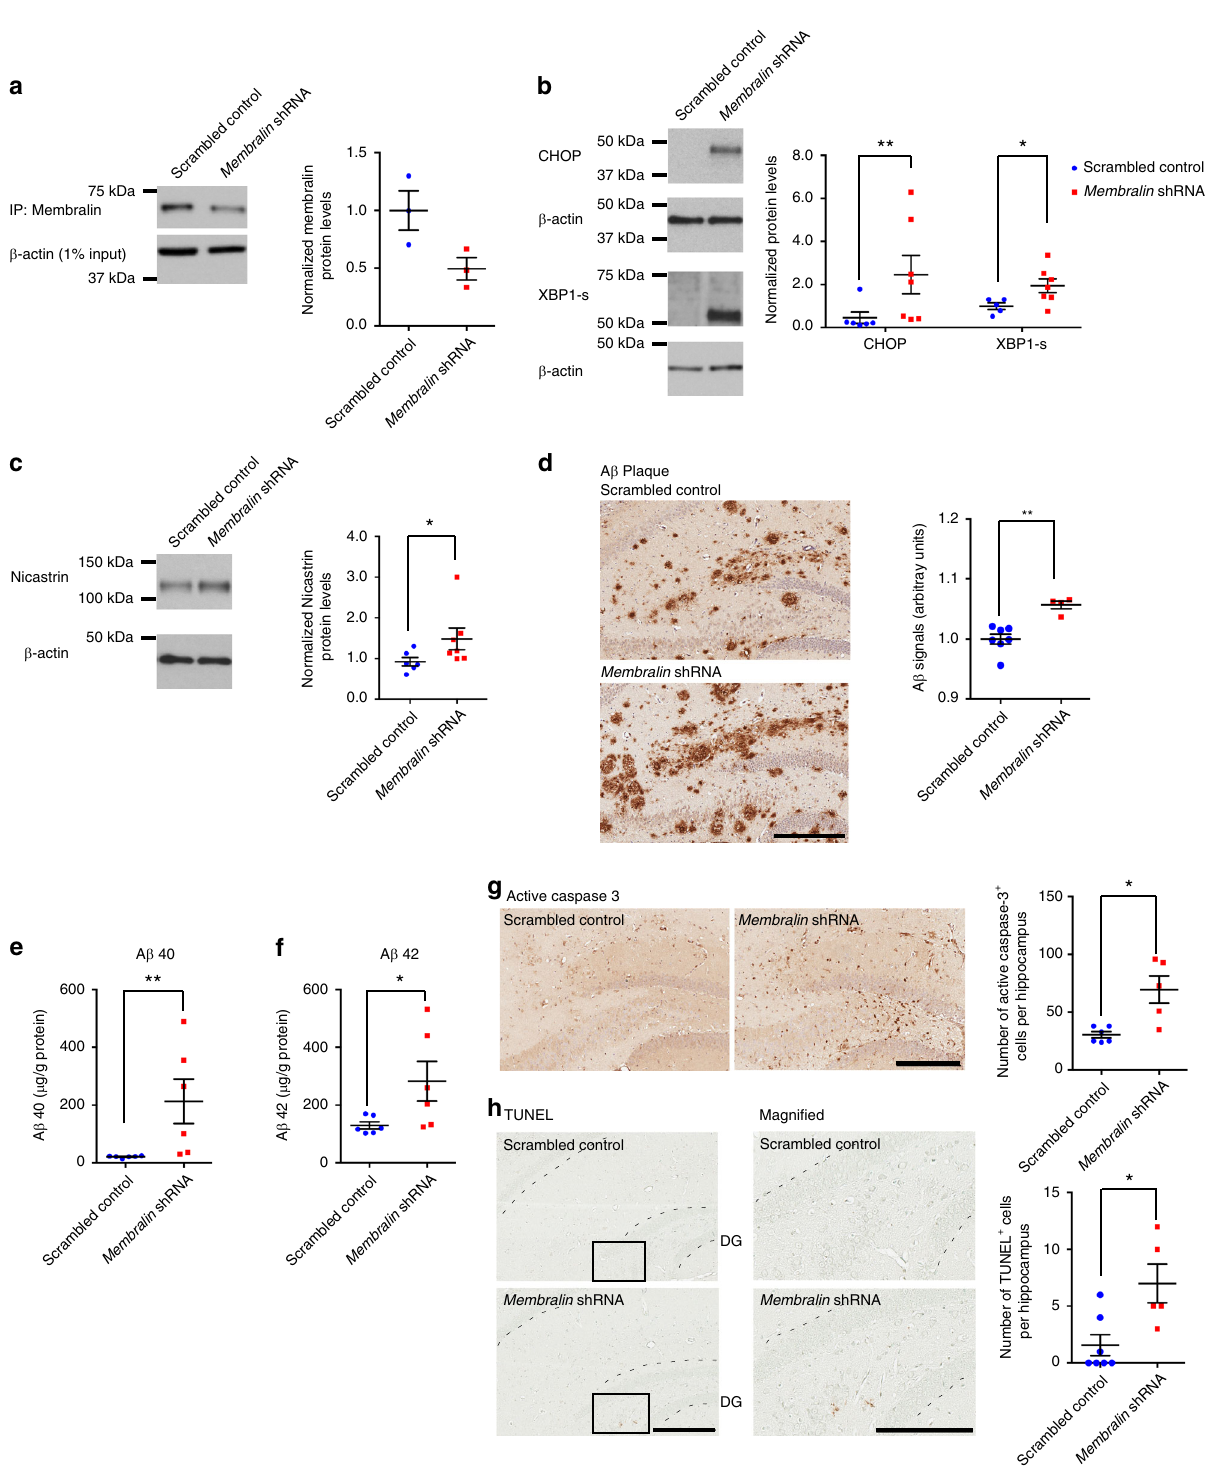
Fig. 6 Modulation of membralin expression in TgCRND8 mice. a Membralin protein levels from TgCRND8 mouse hippocampus injected with scrambled control or membralin shRNA constructs. Protein levels were determined by immunoprecipitation and immunoblot using an anti-membralin antibody. Protein levels were normalized relative to β -actin ( n = 3 mice per group). b XBP1-s and CHOP protein levels from TgCRND8 mouse hippocampus injected with scrambled control or membralin shRNA constructs. c Nicastrin protein levels normalized to β -actin in the hippocampus of scrambled control ( n = 6) and membralin shRNA ( n = 7) injected mice. d A β plaque staining and quanti fi cation was determined by staining with the MOAB2 A β antibody in the DG region ( n = 7 for scrambled control group; n = 4 for membralin shRNA injected animals). e Human A β 40 and A β 42 levels in hippocampal lysates from 6-8-month- old TgCRND8 mice injected with scrambled control or membralin shRNA lentiviruses were determined by ELISA ( n = 6 mice per group). g , h Histological analysis of 6-8-month-old TgCRND8 mice injected with scrambled control or membralin shRNA lentiviruses. Presence of active (cleaved) caspase 3 and apoptotic TUNEL staining in the dentate gyrus (DG) region and quanti fi cation is presented in g and h , respectively. Data represent mean ± s.e.m. unpaired t -test, * P < 0.05, ** P < 0.01, and *** P < 0.001. Scale bars, 300 µ m (left) and 200 µ m in magni fi ed images